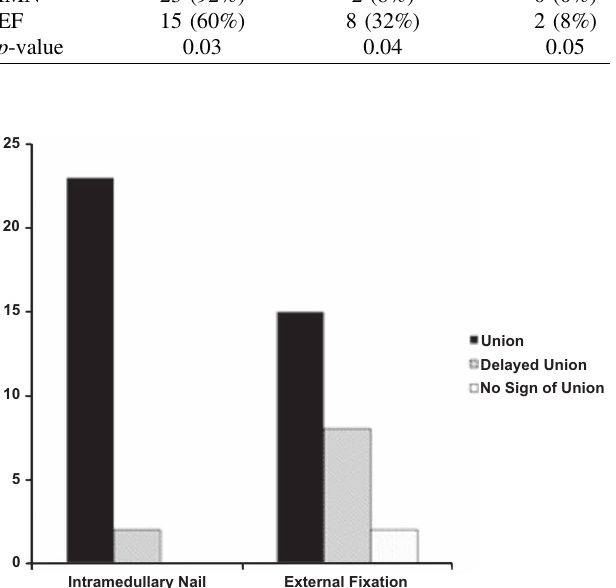
Figure 2. Progress to fracture union at the three month follow-up visit in the IMN and EF groups.